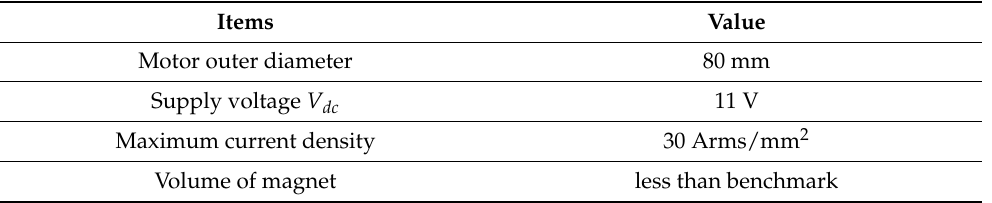
Figure 6. Operation characteristics of benchmark motor model. Table 3.